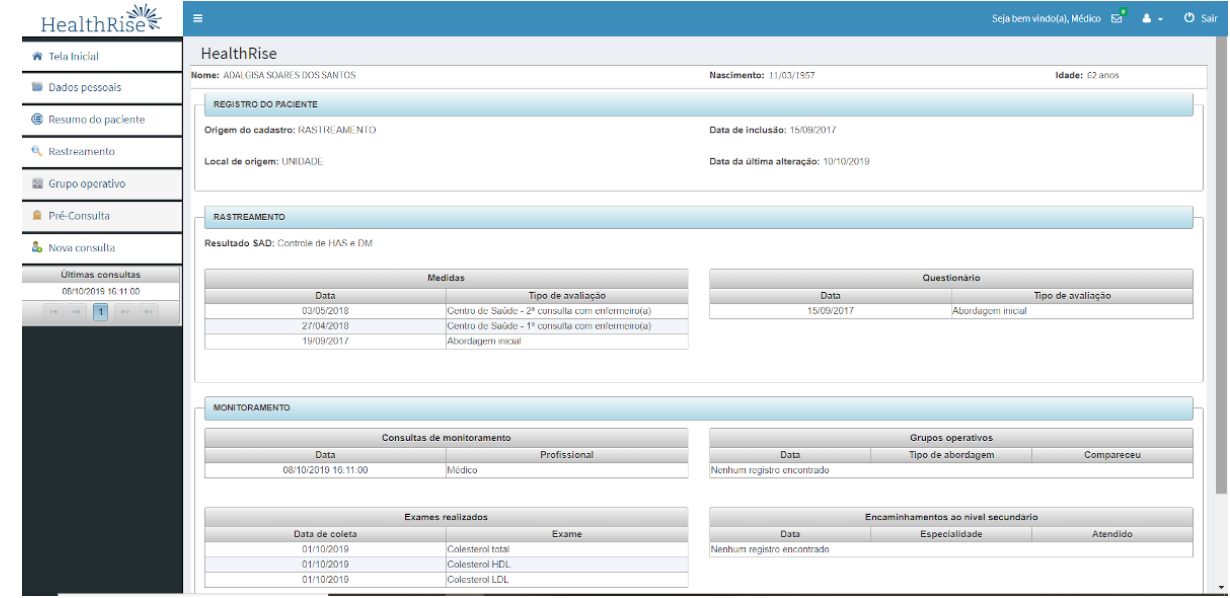
Figure 6. Patient summary